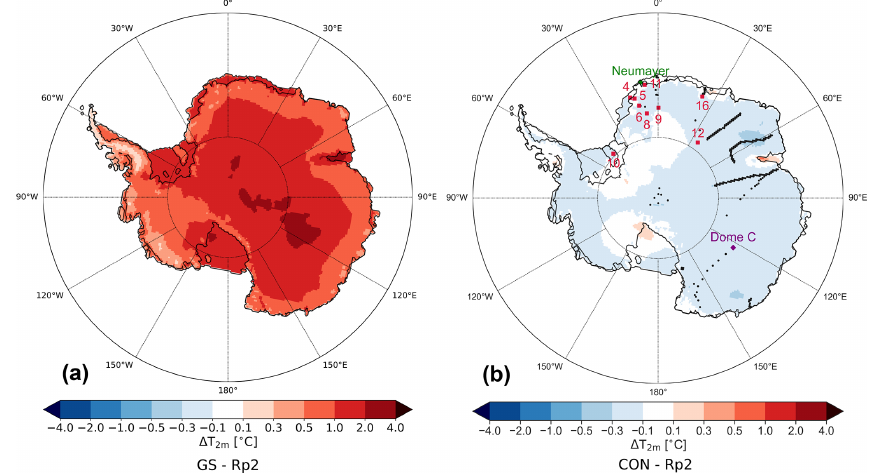
Figure 2. Mean yearly-averaged 2m temperature ( T 2m ) difference with Rp2 for (a) GS and (b) CON for 1985–2018, with positive values indicating a temperature increase with respect to Rp2. SMB measurement locations are shown in black, the numbered AWS in red, Neumayer in green and Dome C in